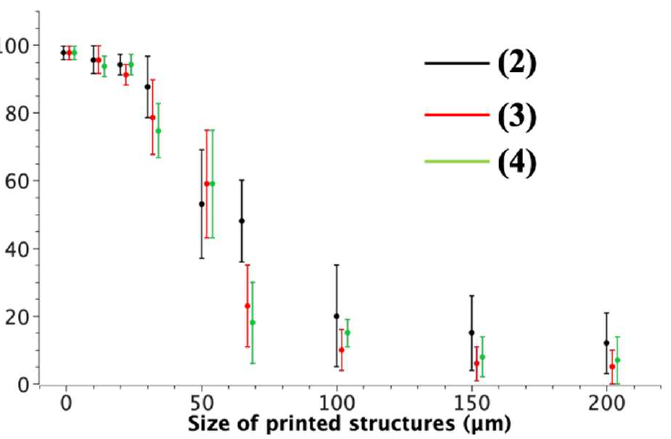
Figure 6. Polymorphs’ composition versus size in printed structures of compounds 2 , 3, and 4 .